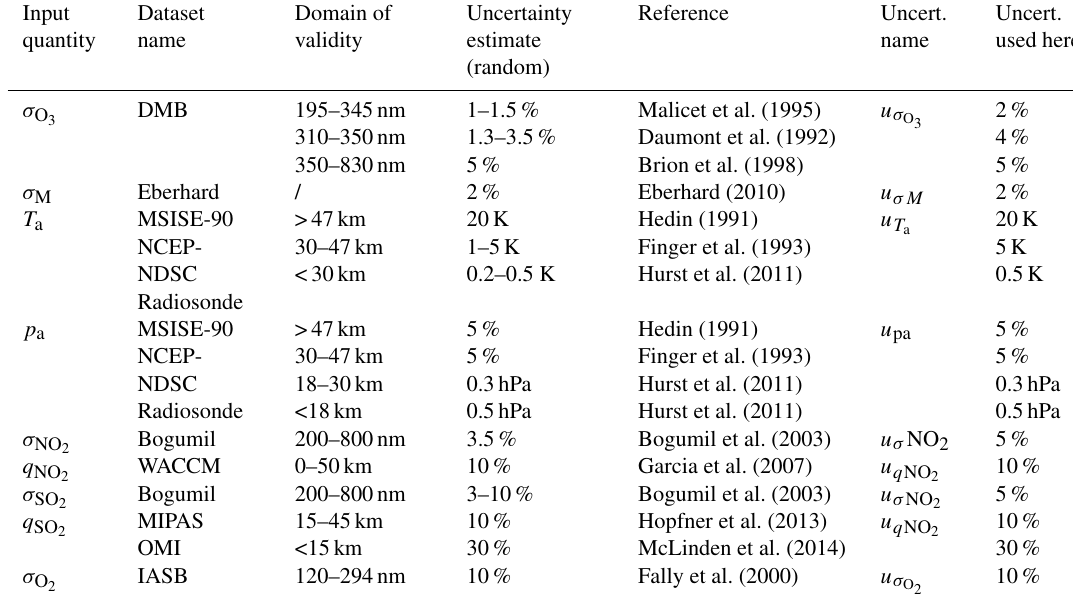
Table 3. Input quantities and their uncertainty used to compute the ozone uncertainty budget presented in Figs. 16 and 17.